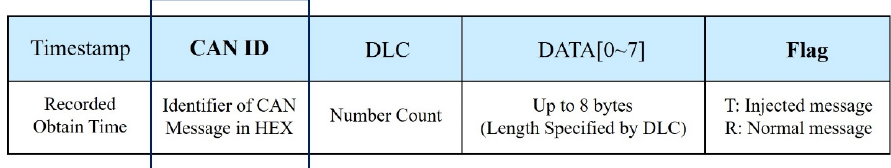
Figure 1. Message format of the Controller Area Network (CAN) bus packets.